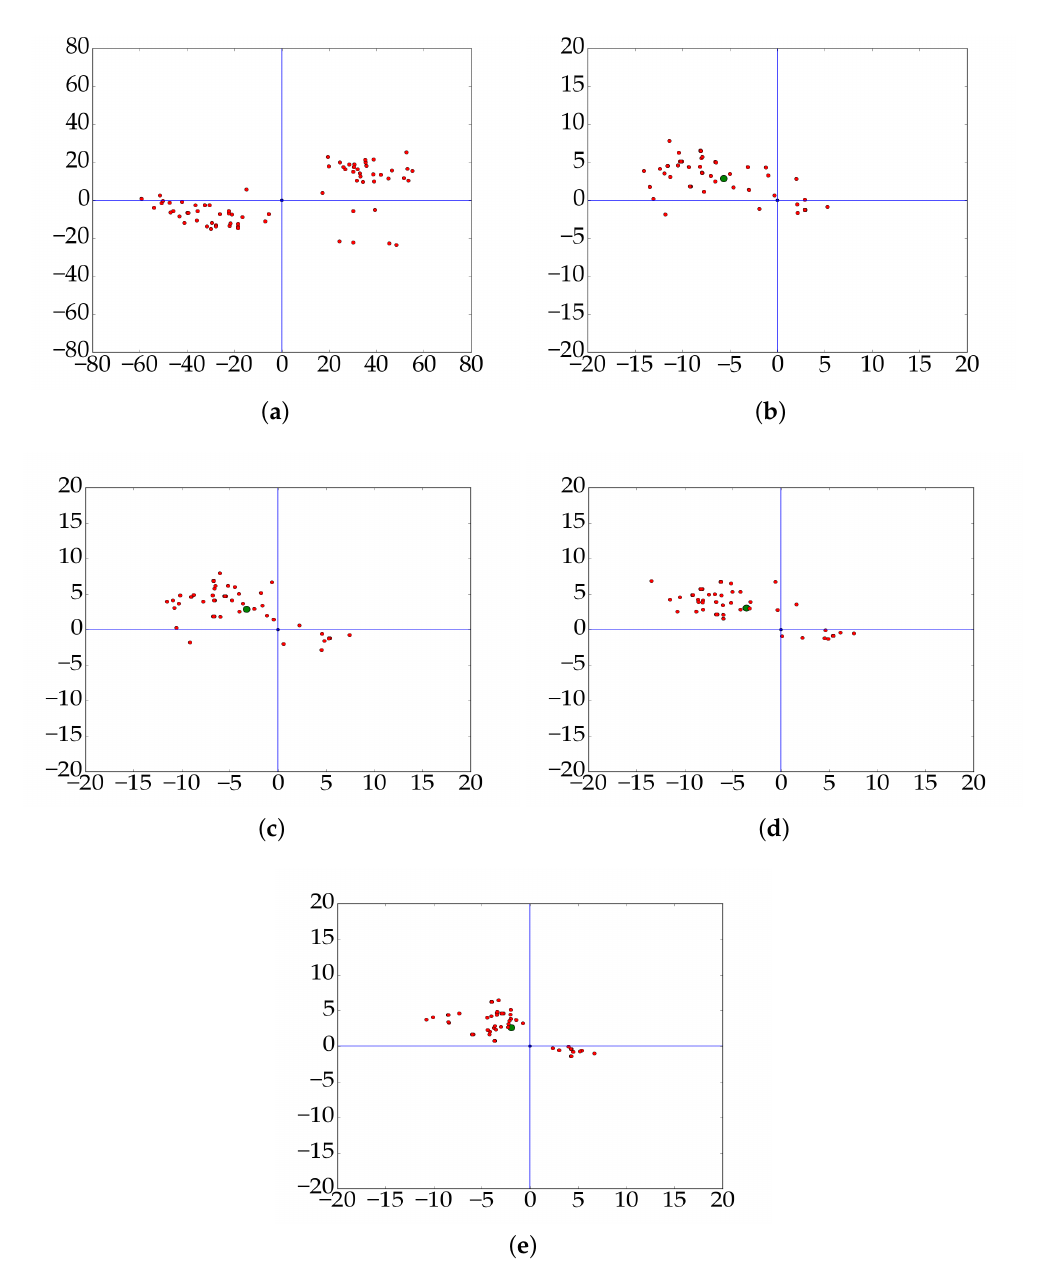
Figure 9. Error distribution of all check points before and after block adjustment. ( a ) is all check points’ error distribution before block adjustment; ( b ) is all check points’ error distribution after the block adjustment procedure with weight strategy 1; ( c ) is all check points’ error distribution after the block adjustment procedure with weight strategy 2; ( d ) is all check points’ error distribution after the block adjustment procedure with weight strategy 3 and ( e ) is all check points’ error distribution after the block adjustment procedure with weight strategy